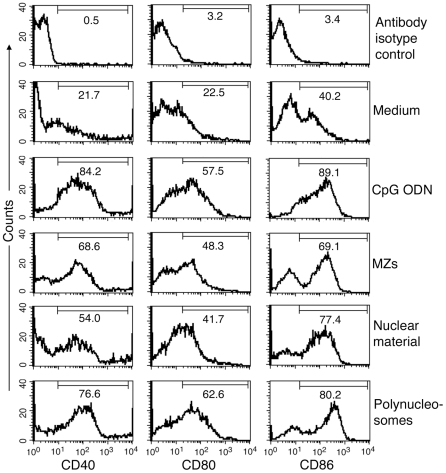

P. falciparum nuclear material and polynucleosomes induce the maturation of DCs.FL-DCs prepared from the bone marrow cells of WT mice were plated in 24-well plates and stimulated with merozoites (MZs), parasite nuclear material or polynucleosomes. DCs stimulated with MZs or CpG ODN was used as controls. The upregulated surface expression of costimulatory molecules, CD40, CD80 and CD86, were analyzed by flow cytometry. The percentages of DCs that are positive to each costimulatory molecule are indicated. Data are representatives of two independent experiments.